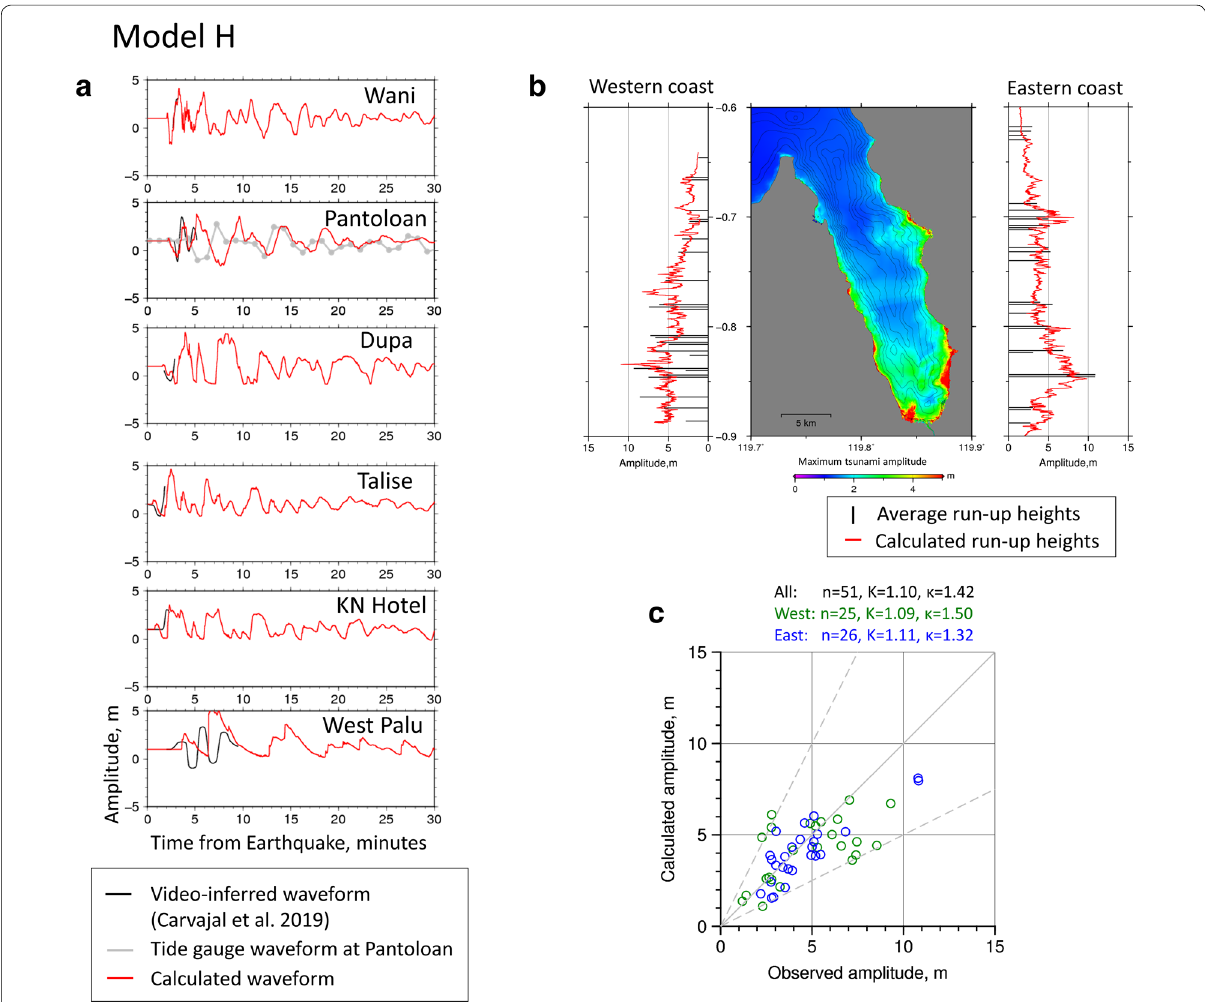
Fig. 9 Calculated tsunamis for source model H. The most probable source model H (LSC2 and LSC5 in the northern and southern parts of the bay, respectively, with no earthquake source; see text) is shown. a Same as Fig. 4a for source model H. b Same as Fig. 4b for source model H. c Comparison of calculated and observed run-up heights. The heights on the eastern (blue) and western coasts (green) for model H are shown. Aida’s (1978) K and κ were calculated from these data and are reported for each coast as well as for all sites (black). The solid and dashed lines indicate the ratio of 1.0 between the calculated and observed run-up heights and the ratios of 2.0 and 0.5,